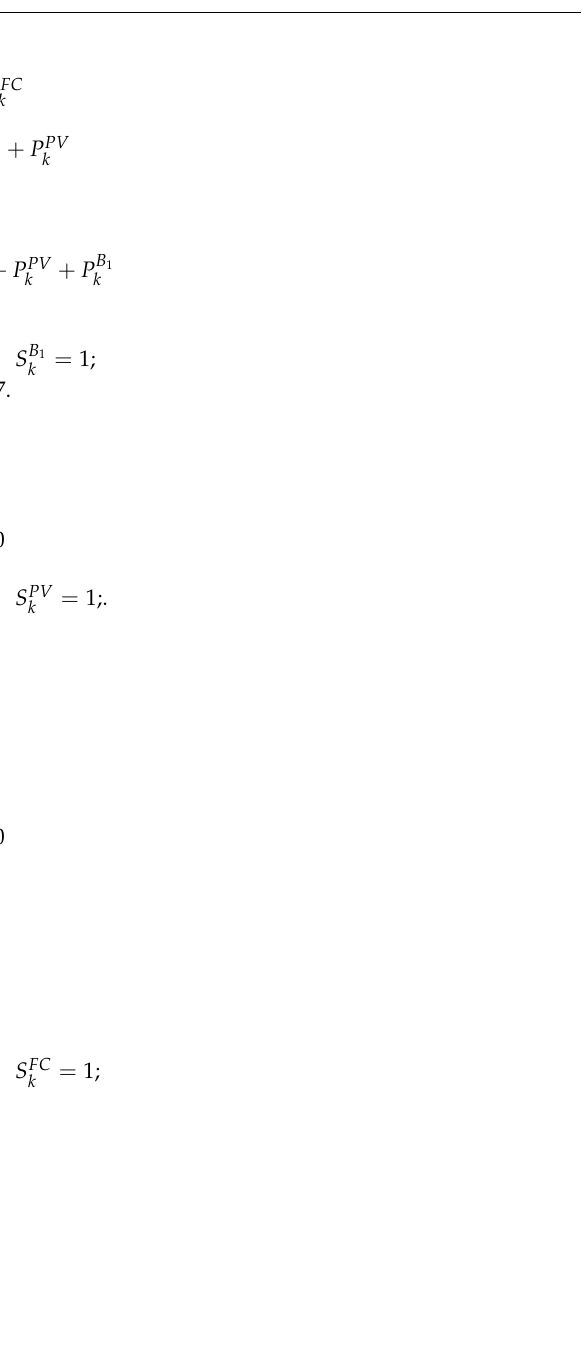
Algorithm 1. Energy management